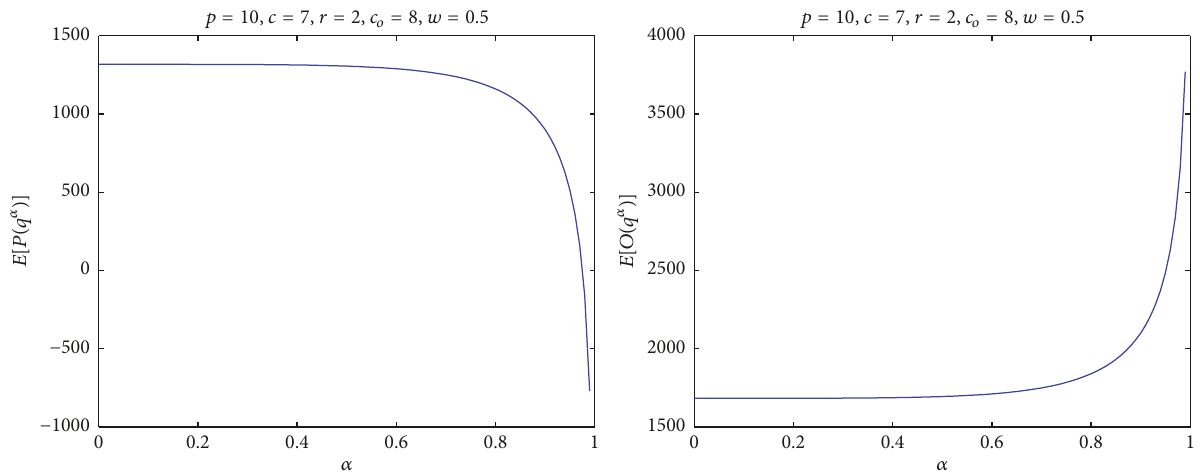
Figure 3: 𝐸[𝑃(𝑞 𝛼 )] and 𝐸[𝑂(𝑞 𝛼 )] with different confidence level 𝛼